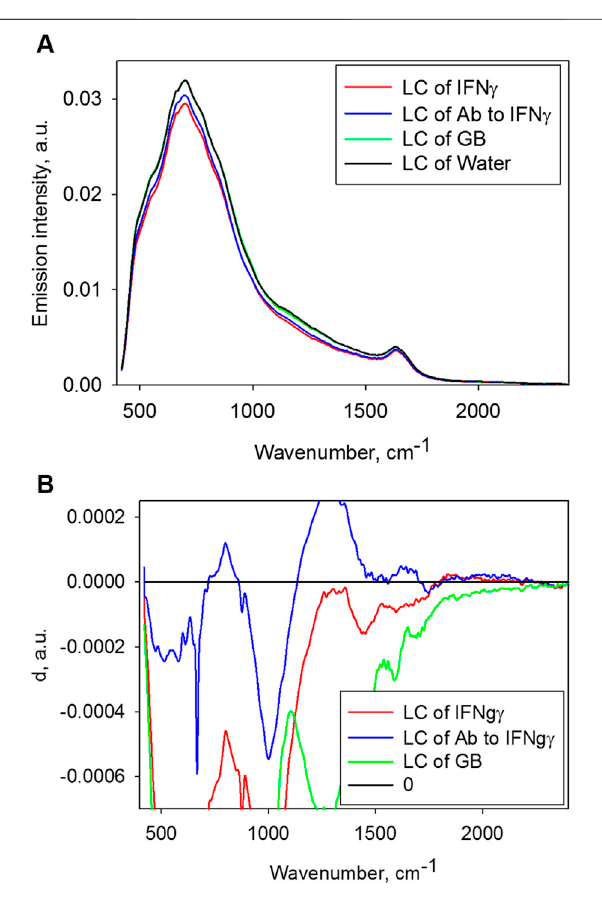
FIGURE2|(A) Emission spectraofthetestsamples. (B) Comparison of